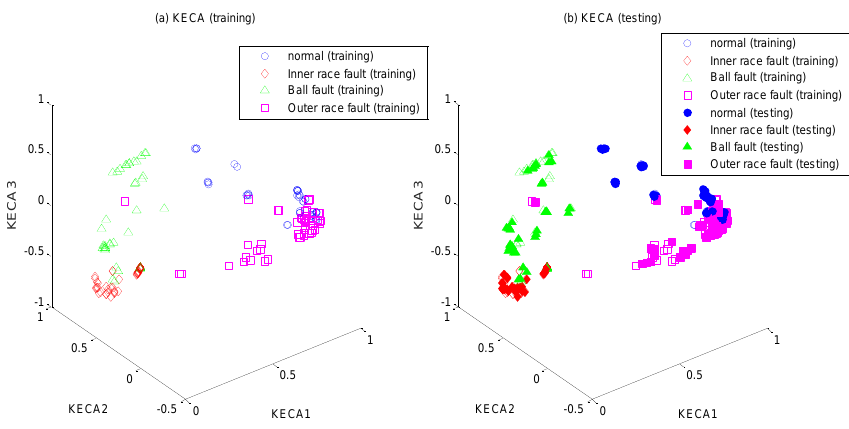
Figure 7. Feature extraction with KECA: ( a ) training samples, ( b ) testing samples.